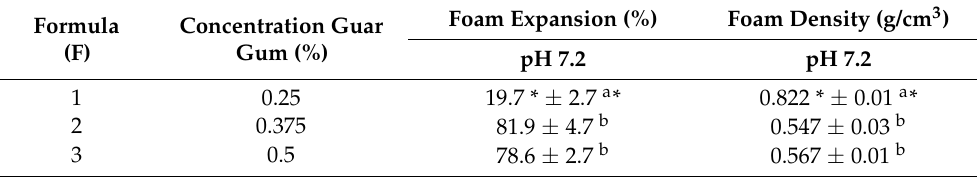
Table 5. Foam expansion and foam density of the formulations at final pH of the system